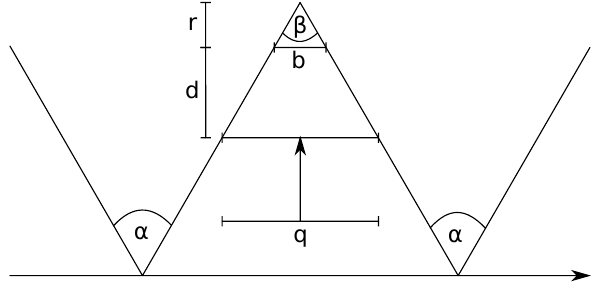
Figure 10: Birds-eye view on the movable hiding